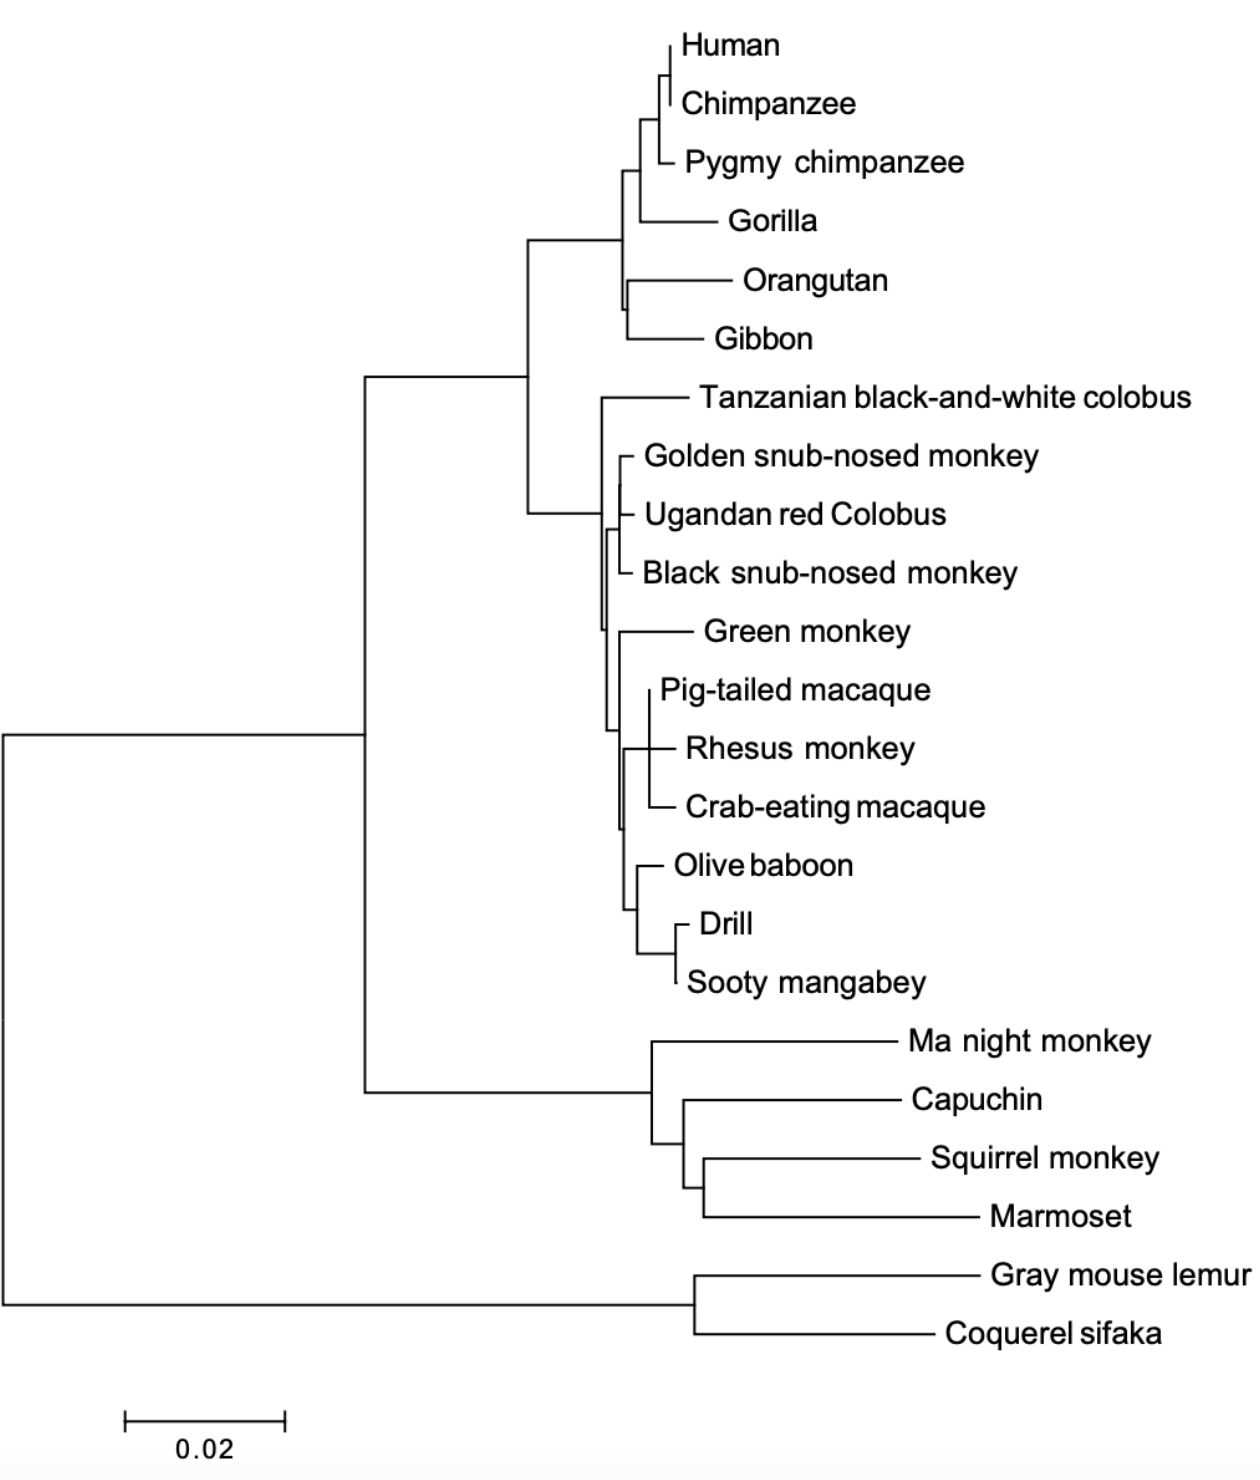
Figure 6. Phylogenetic tree of PRLR proteins from various primates. The tree was built using MEGA version 6.06 by the NJ method and further bootstrap analysis of 1000 replicas. Clades are in linage specific manner.